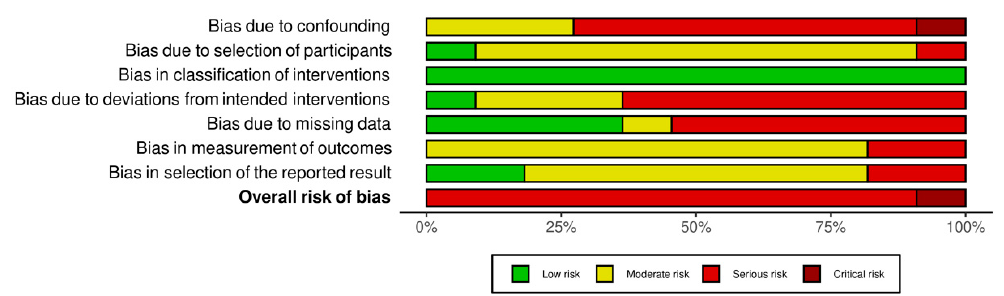
Figure 4. Risk of bias in non-randomized control trials (green: low bias risk; yellow: moderate bias risk; red: serious bias risk; brown: critical bias risk; blue: no information).